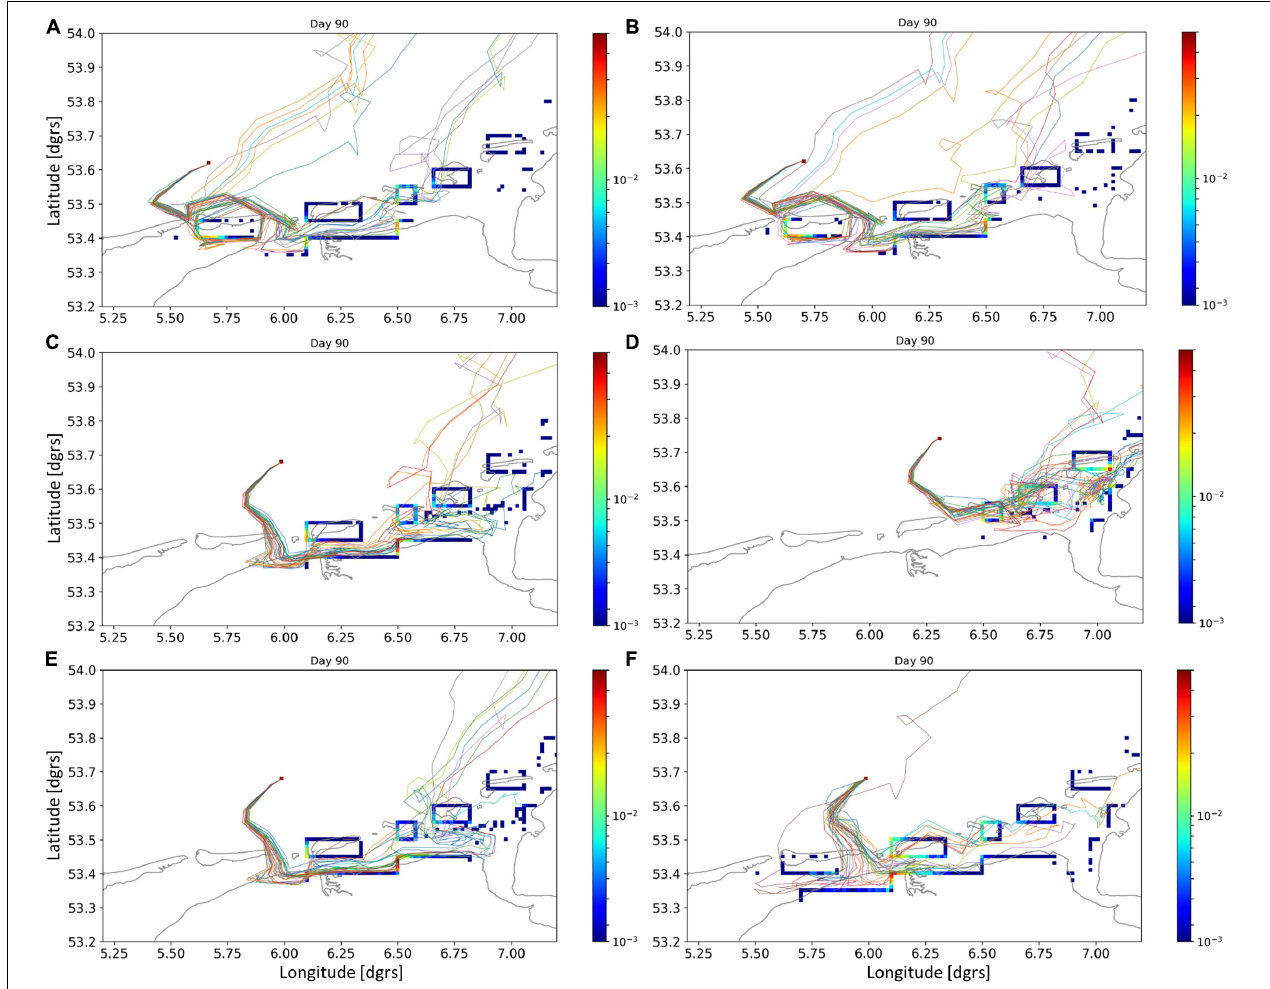
FIGURE 8 | Results of releases of particles representing HDPE pellets from positions of estimated container loss (Rijkswaterstaat, pers. comm.) within the area of high release probability ( Figure 7 ). Colors represent the fraction of particles released that arrived in a 1 × 1 km rectangle. (A–D) For the four estimated positions of container loss with a vertical velocity of 0.06 ms − 1 and a diffusion coefficient of 0.5 m 2 s − 1 . (E,F) : As (C) , but with a vertical velocity of 0.05 ms − 1 and a diffusion coefficient of 12 m 2 s − 1 ,